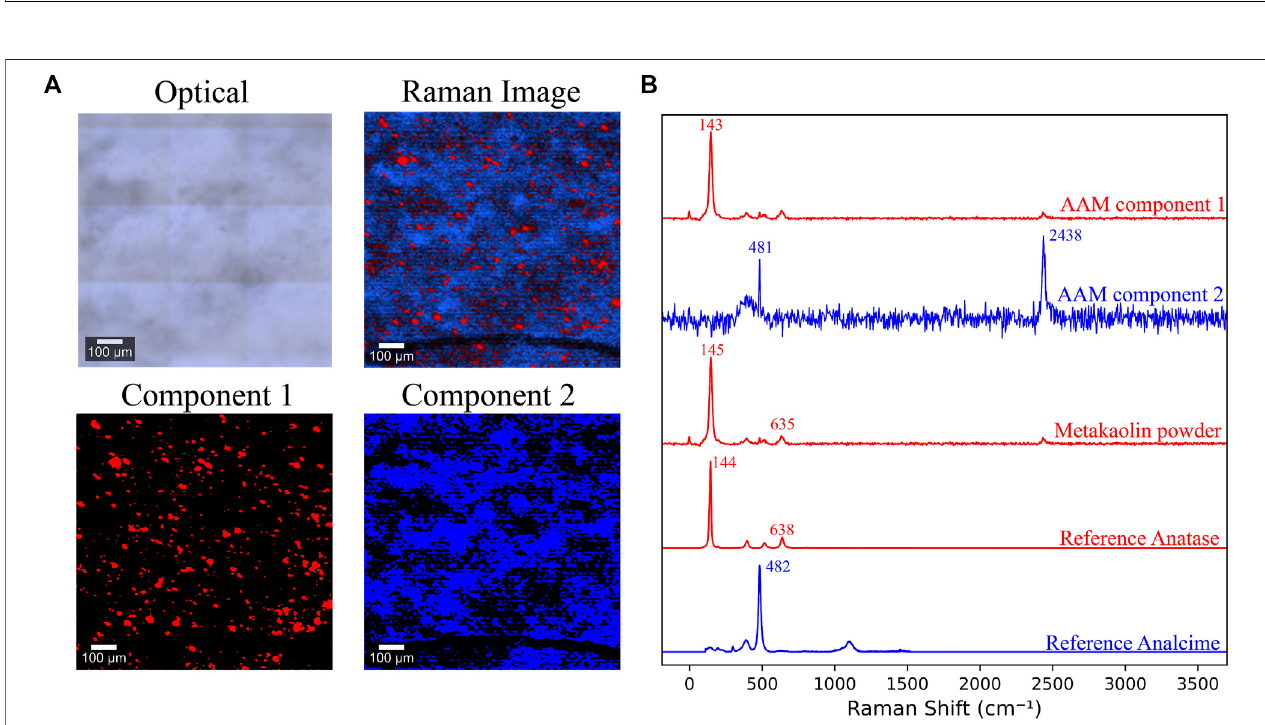
FIGURE 7 | (A) Optical image, combined Raman image, and components maps of a 7 day old AAM sample (B) Raman spectra of AAM ’ s components, raw metakaolin powder, reference Anatase (TiO 2 ) (Zhang et al., 2000), and reference Analcime (Na(AlSi 2 O 6 ) · H2O) (Presser et al., 2008; Tsai et al., 2021).